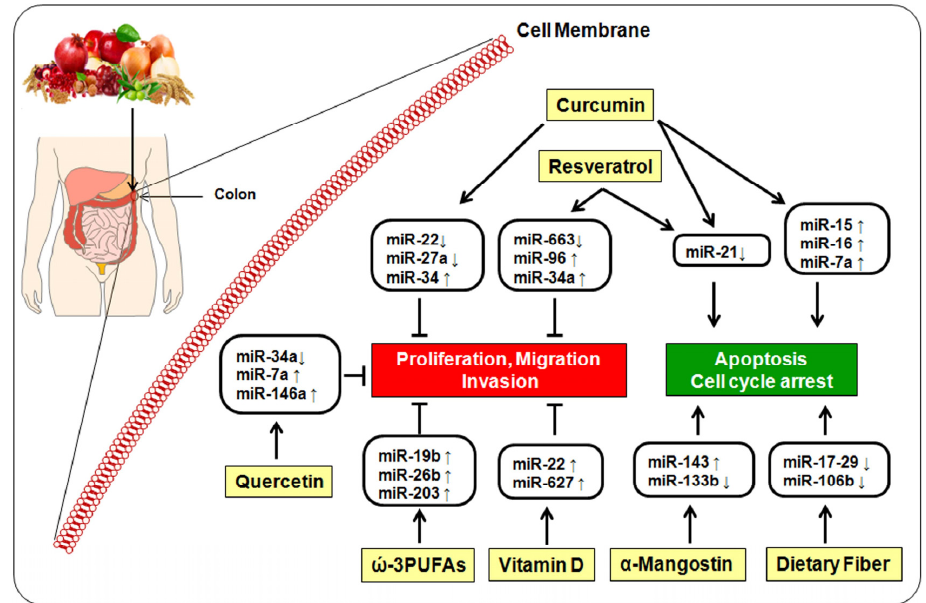
Figure 2. The protective role of bioactive dietary components in colorectal cells. Molecular mechanisms such as proliferation migration, invasion and apoptosis are tightly controlled by miRNAs-based epigenetic mechanisms.